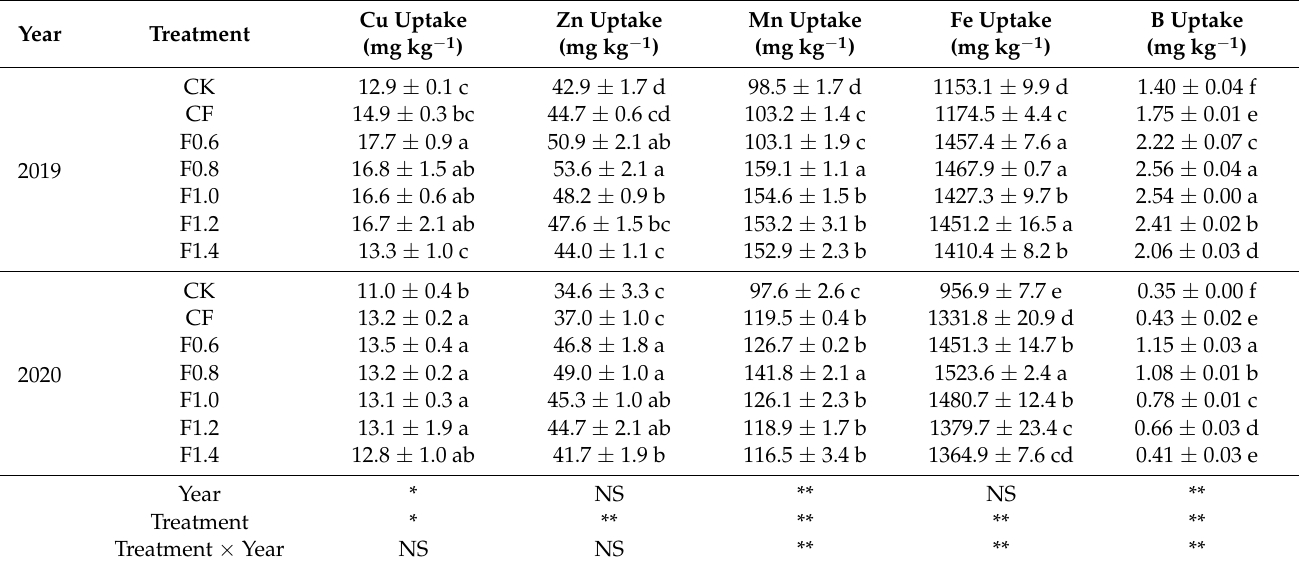
Table 4. Changes in Cu, Zn, Mn, Fe and B absorption of cotton under different fertilization